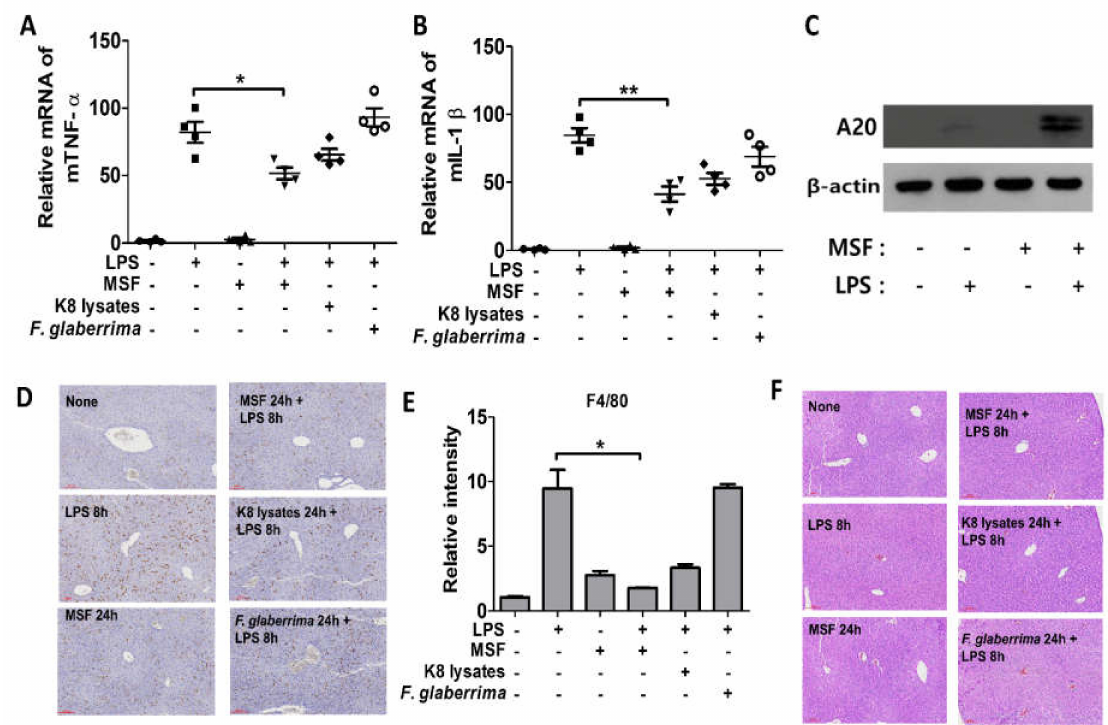
Figure 8. MSF reduced LPS-induced liver damage in mice. Liver homogenates of BALB/c mice (7 weeks old, 8 mice/group) were collected 8 h after i.p. injection of 20 mg/kg LPS following pre- injection of PBS, 400 µ g/mouse MSF, 400 µ g/mouse K8 lysates, or 5 µ g/mouse of F. glaberrima for 24 h. The mRNA levels of TNF- α ( A ) and IL-1 β ( B ) were measured by real-time PCR. ( C ) The protein level of A20 was quantified by western blot. ( D ) Liver immunohistochemistry of F4/80 and ( E ) relative intensity of F4/80. ( F ) Liver hematoxylin and eosin staining. Statistical analyses were conducted with an unpaired two-tailed t -test. * p < 0.05; ** p <